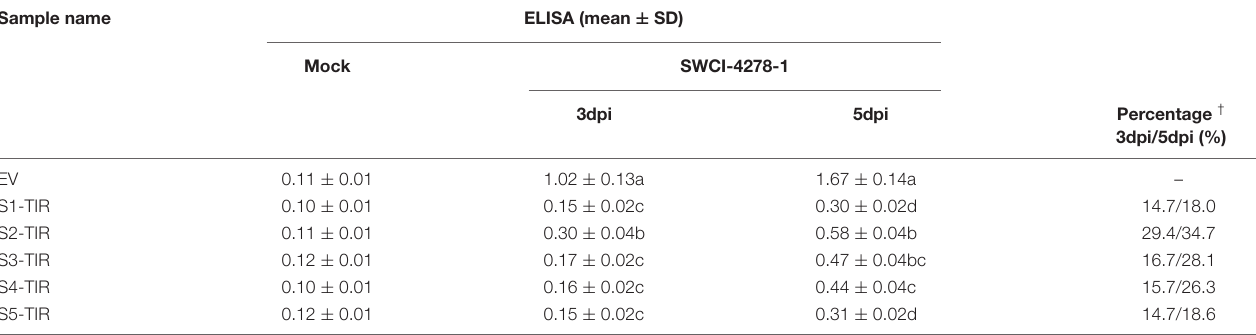
TABLE 3 | The virus content in N. benthamiana leaves from DAS-ELISA analysis for different TIR